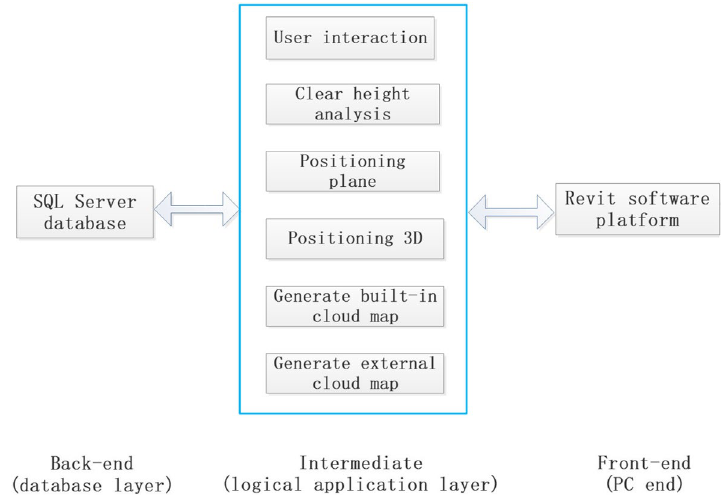
Fig. 2 Program architecture for intelligent generation of clear height cloud